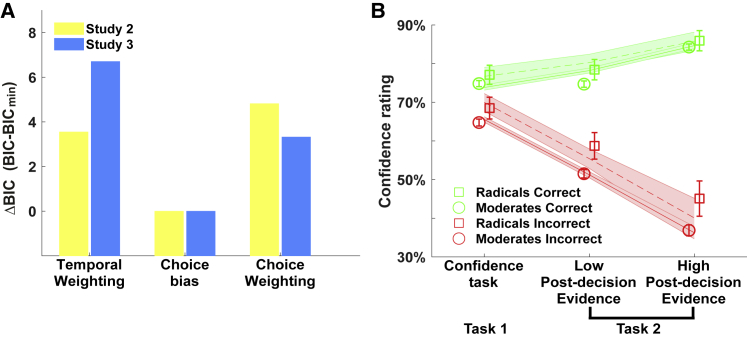
Individual Differences in Radicalism Are Captured by a Choice Bias Model(A) A choice bias model fitted to the confidence data across both tasks best accounted for variations in a composite measure of radicalism (summed factor scores of dogmatic intolerance and authoritarianism). We compared among three computational models within multiple regressions that predicted radicalism from fitted model parameters. We present the BIC of each regression against the lowest BIC in the model set (the best model has a difference in BIC of zero).(B) Radicals reduce their confidence less when new evidence indicates they are wrong (reduced disconfirmatory evidence integration). To visualize this effect, we combined data from study 2 and study 3 and compared the 10% most radical participants (based on the composite measure) against the rest of the sample. Aggregate confidence ratings are separated according to whether the decision was correct (green) or incorrect (red). Markers (circles and squares) show raw data (group averages ±95% confidence interval) for each condition. Lines (solid line, moderates; dashed line, radicals) show posterior predictives from the choice bias model. Predictions were simulated from best-fitting parameters and represent group averages ±95% confidence interval. Task 1, confidence task; task 2, post-decision evidence integration task.See also STAR Methods and Figures S3 and S4.